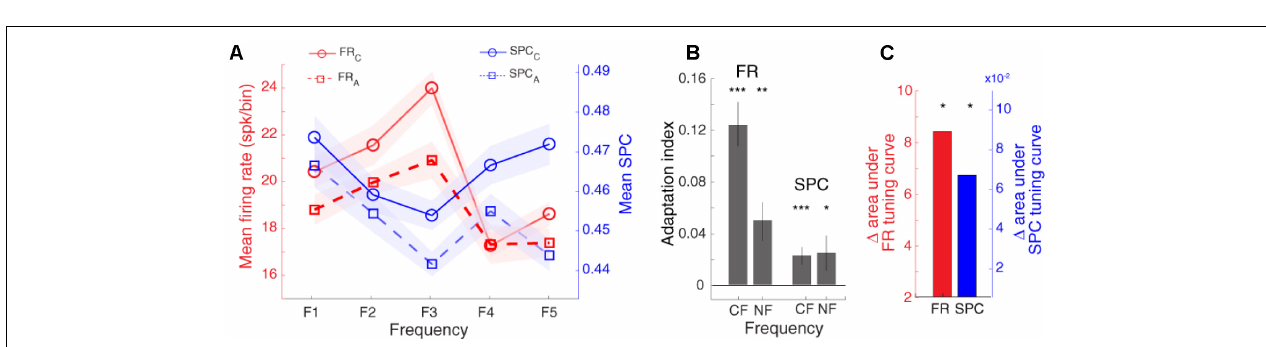
FIGURE 5 | Adaptation modulates spike-phase coupling (SPC) tuning curve. (A) The firing rate and SPC strength relative to different stimulus frequencies are averaged for the population of neurons. The x -axis shows different frequencies and y -axes represent the normalized spike rate (solid-curve) and SPC strength (dashed-curve). The spike rate tuning curve and the strength of SPC tuning curve were suppressed in the adapting condition (blue) compared to the control condition (red). (B) Statistical comparison of adaptation effect. Adaptation Index ( y -axis) that was achieved from the firing rate, and SPC analyses. The suppression due to adaption is significant in the characteristic frequency (CF) and its neighboring frequencies (NF; f1, f2, f4, f5) ( t -test; * p < 0.05, ** p < 0.01, *** p < 0.001). This effect is observed both based on firing rate and SPC. (C) (cid:49) area under tuning curve. The red and blue bars show the difference between the area under solid and dashed curves in firing rate and SPC tuning curves, respectively.